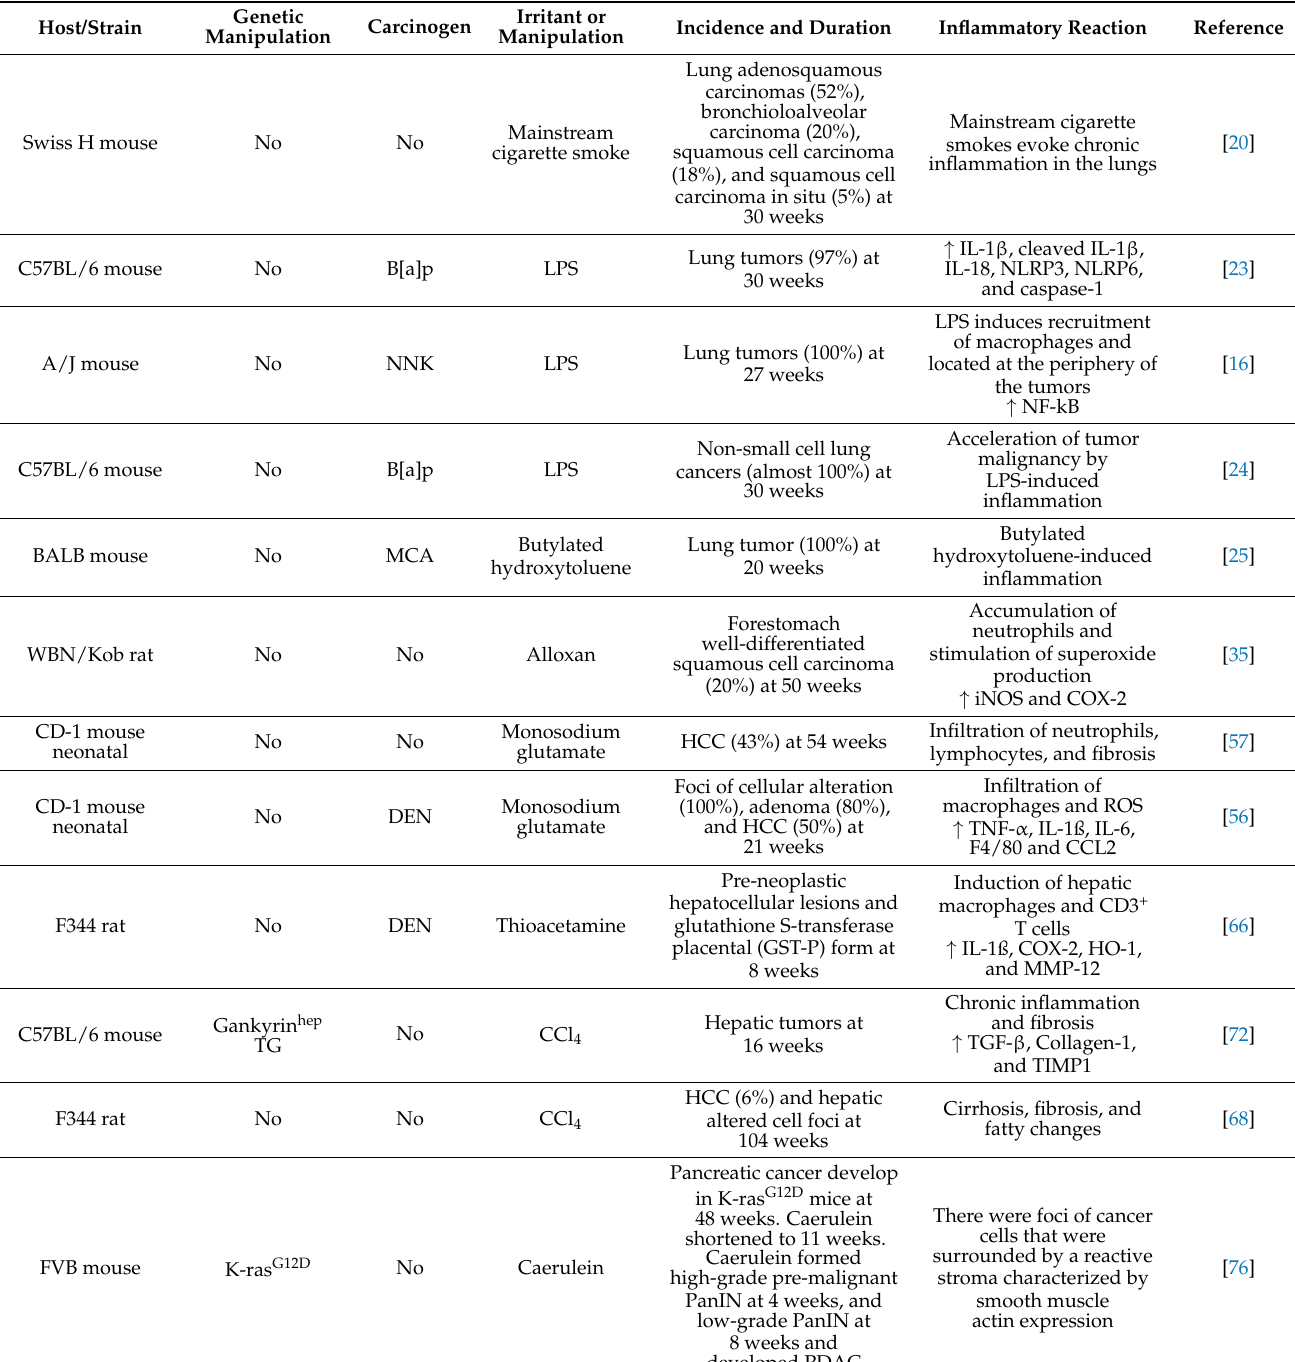
Table 1. Chemical or irritant-induced inflammation-related carcinogenesis